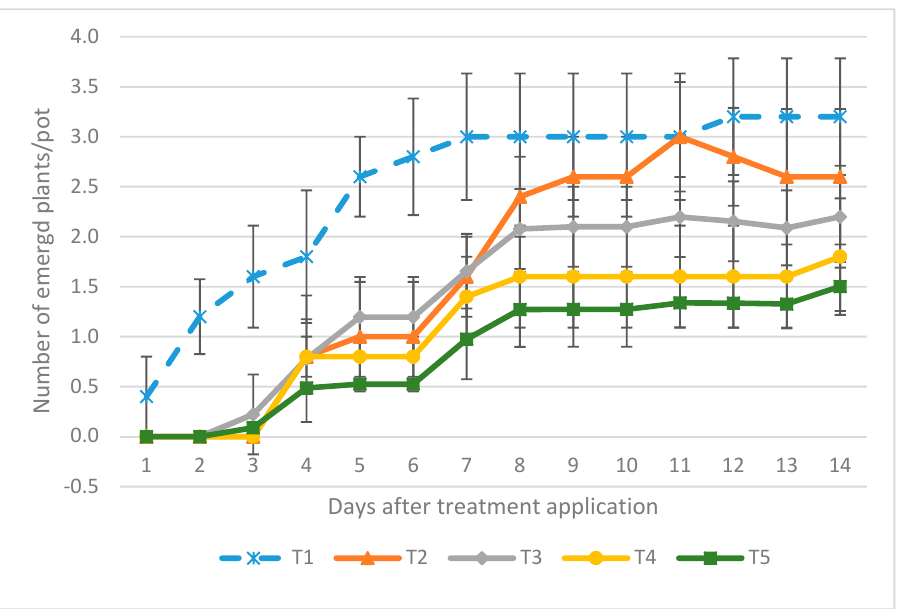
T5: 100% OVW). Error bars represent ± standard error. Bars sharing the same letter are not statistically different according to Tukey’s HSD test (at P < 0.05).